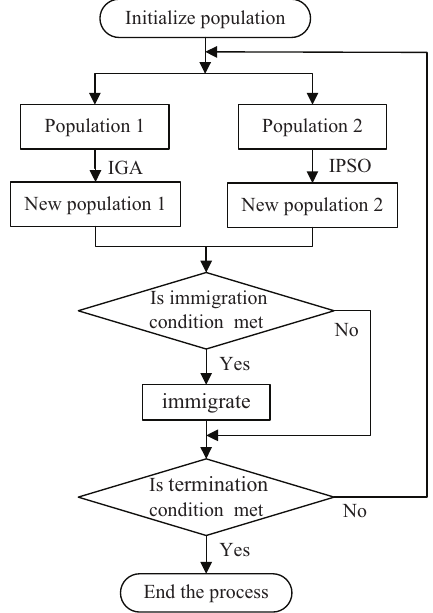
Figure 10. The flow chart of